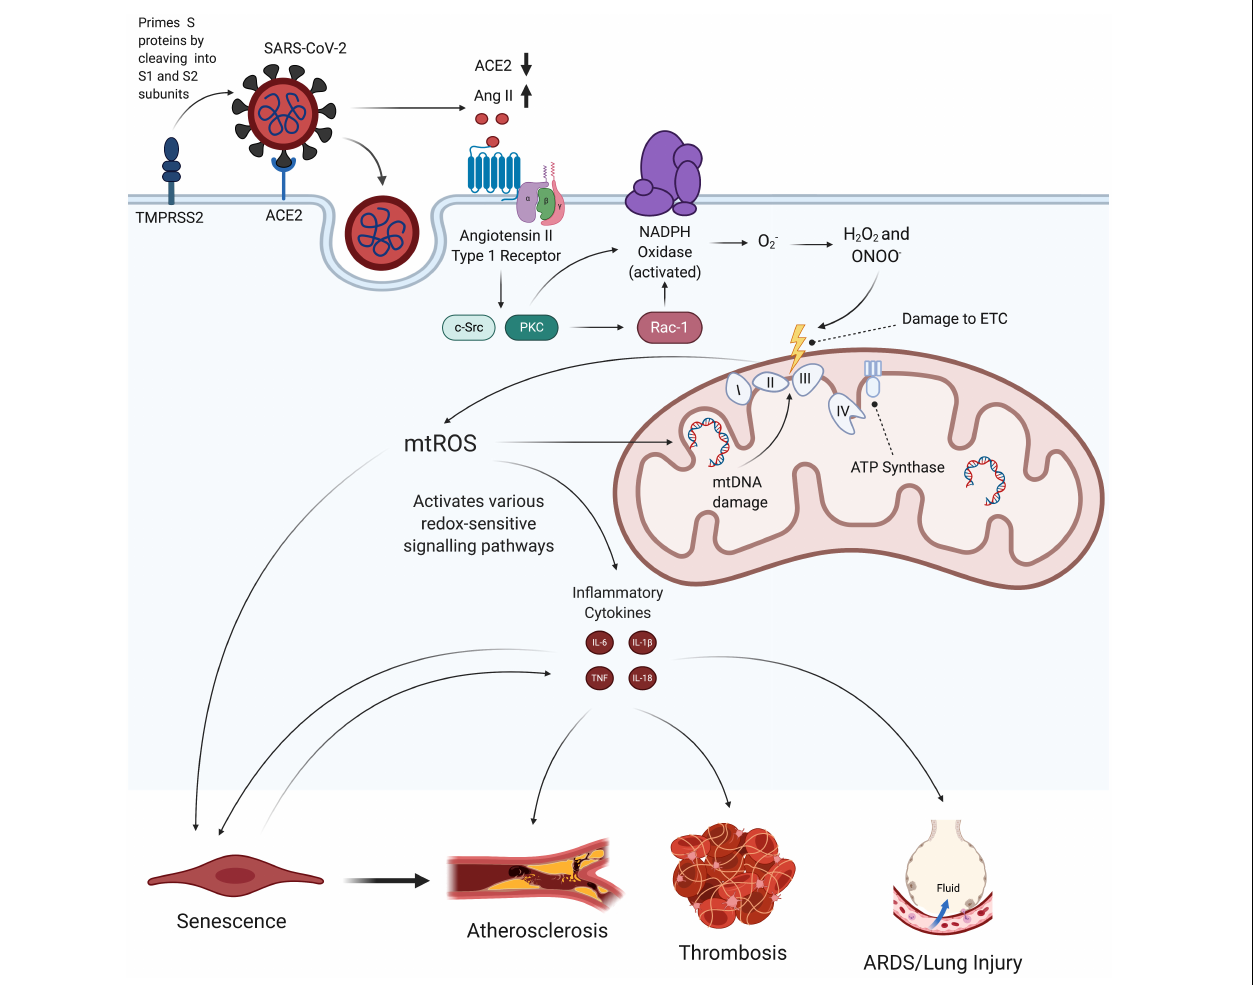
FIGURE 1 | Hypothesized effects of SARS-CoV-2 on mitochondrial dysfunction, increased mtROS production, and subsequent endothelial pathologies. SARS-CoV-2 infection begins when its spike proteins are proteolytically primed by TMPRSS2, which enables them to bind to ACE2 and initiates viral endocytosis into the EC. This increases the amount of Ang II binding to AT 1 R, which, in turn, activates NADPH oxidase and subsequently induces increased production of mtROS via oxidative and nitrosative damage to the ETC. These excess mtROS mediate signaling pathways that elevate production of inflammatory cytokines. mtROS also inflict mitochondrial and nuclear damage that perpetuate mitochondrial dysfunction and further promote inflammatory senescence. These self-feeding interactions greatly increase the risk of atherosclerosis, thrombosis, and lung injury in people infected by SARS-CoV-2. TMPRSS2, transmembrane protease, serine 2; ACE2, angiotensin-converting enzyme 2; Ang II, angiotensin II; AT 1 R, angiotensin type 1 receptor; ETC, electron transport chain; mtROS, mitochondrial reactive oxygen species; IL, interleukin; TNF, tissue necrosis factor; ARDS, acute respiratory distress